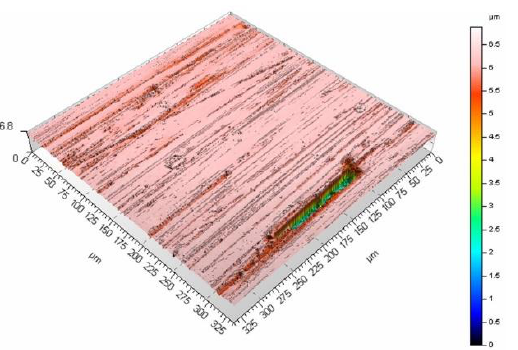
Figure 15. The surface morphology of a smooth surface example (mean roughness: Sa = 0.17 µ m).